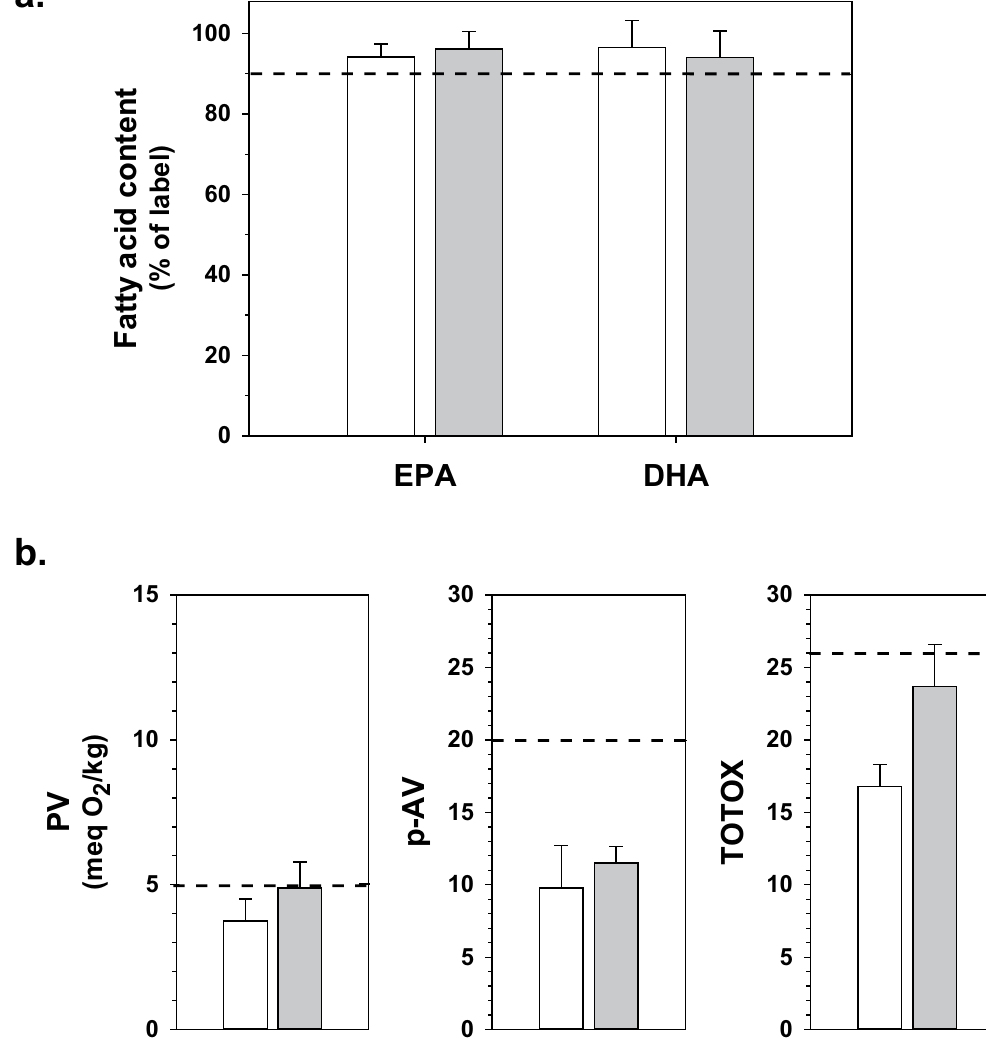
Figure 3. Content of EPA/DHA and oxidative status of several New Zealand fish oil products that were within one year before expiry date (white bars), and after retesting a year later after having passed expiry date (grey bars). Panel a: EPA and DHA content expressed as percentage of labeled content (means ± S.D., n = 5 products). The dashed line indicates the minimum required content of EPA and DHA according to local regulations. Panel b: PV (left), p-AV (middle) and TOTOX (right). Values are means ± S.D., n = 5 products for PV, and n = 3 for p-AV and TOTOX as two products were flavored and could not be tested for p-AV and TOTOX). The dashed lines indicate the maximum levels of PV, p-AV and TOTOX as specified by